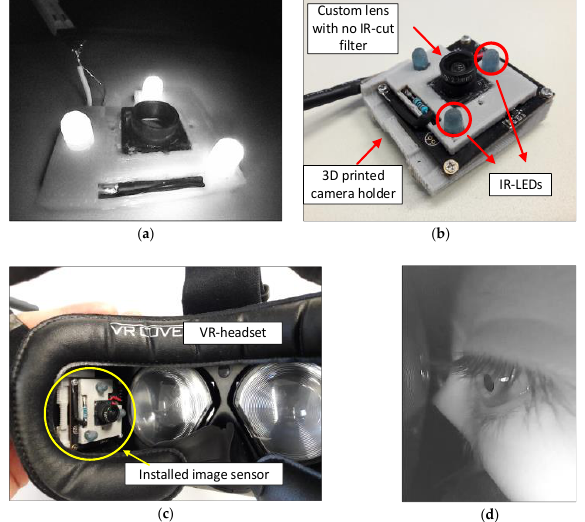
Figure 3. The modification on the monitoring camera: ( a ) Infrared spectrum image for lens mount M8 and IR-LEDs for internal illumination in action; ( b ) Adding of the custom lens with no IR-cut filter, infrared LEDs for eye illumination and custom 3D printed camera holder; ( c ) Installing the camera inside the VR-headset (HTC-Vive); and ( d ) Image sample captured by the camera inside the VR